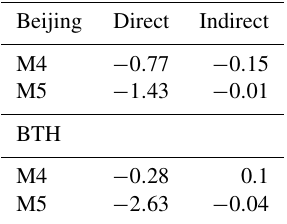
Table 3. Monthly mean (January 2010) aerosol direct radiative forc- ing and indirect radiative forcing (Wm − 2 ) at the top of the atmo- sphere inferred from M4 and M5 (areas marked in Fig.